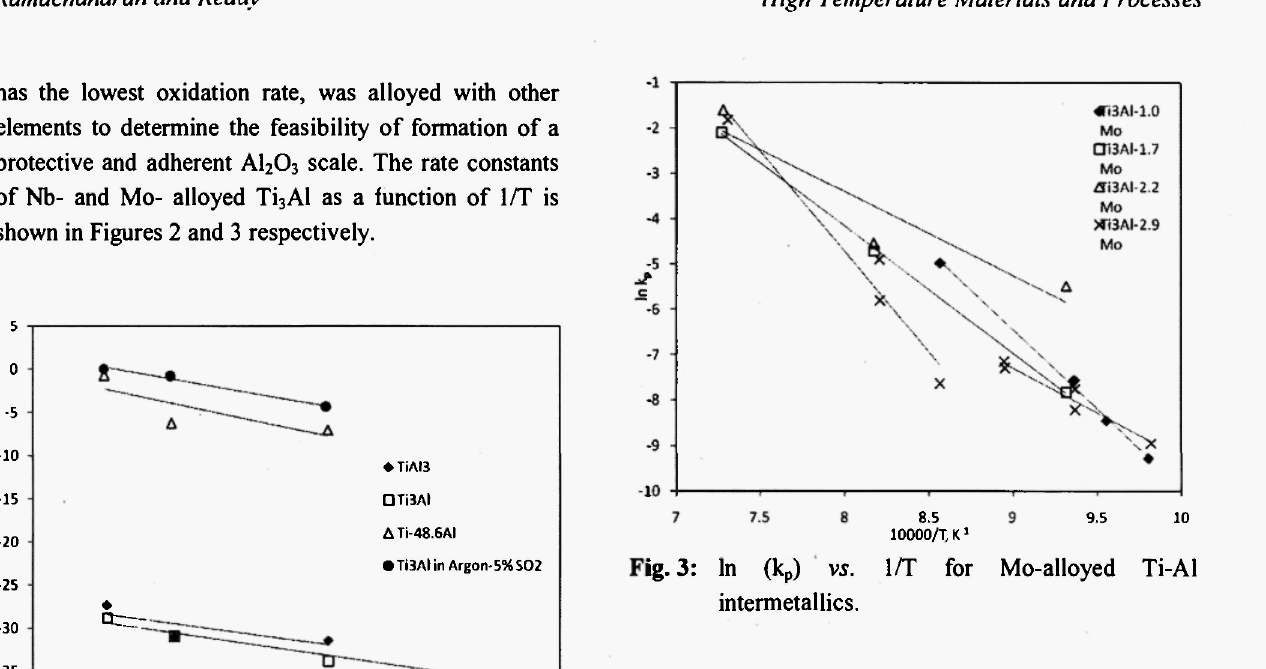
Fig. 1: In (k p ) vs. 1/T for various Ti-Al intermetallics in pure oxygen and Ar + 5% S0 2 mixture.